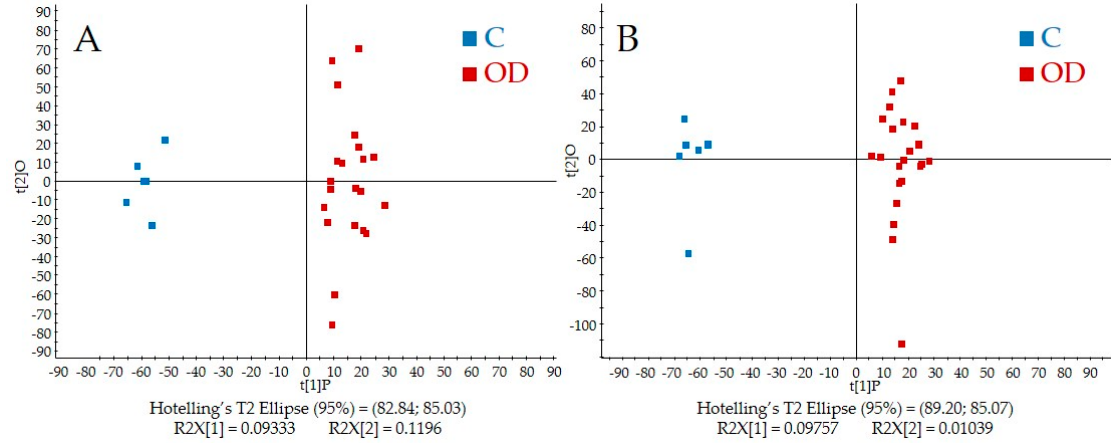
Figure 1. Partial least squares discriminant analysis (PLS-DA) scores plots for both ( A ) positive and ( B ) negative ionization modes. Control samples are shown in blue and samples from overdose subjects are in red.